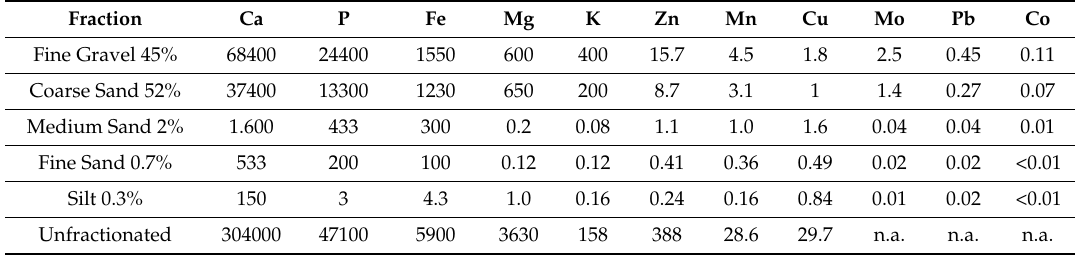
Table 3. Particle size distribution and elemental content of CPMW ( µ